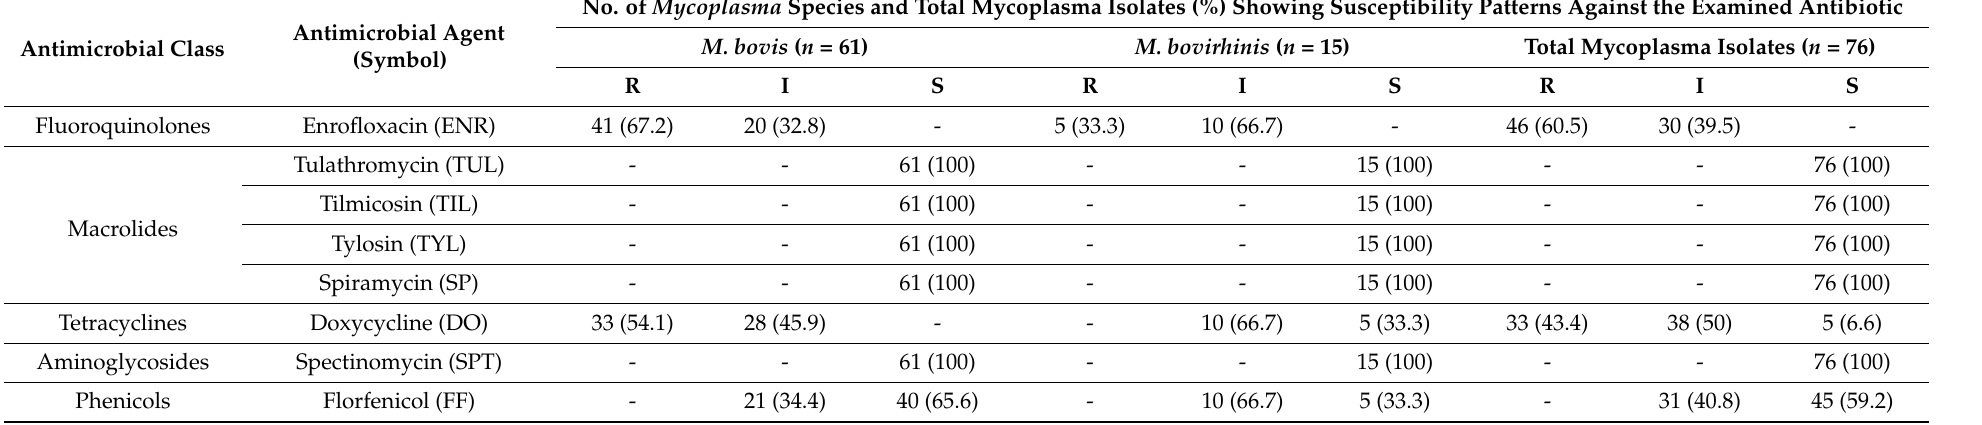
Table 6. Antibiotic susceptibility patterns of total mycoplasma, Mycoplasma bovis, and Mycoplasma bovirhinis